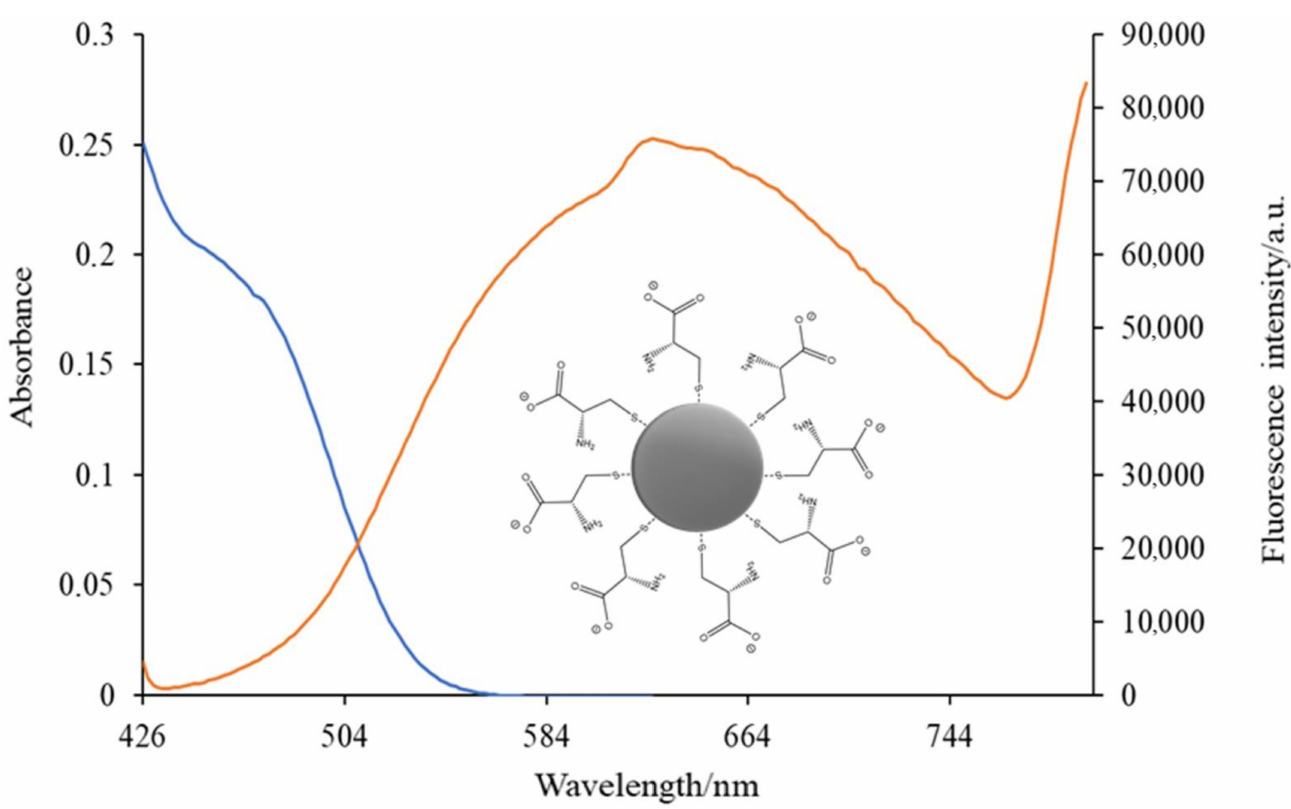
Figure 6. UV–Vis ( left ) and fluorescence ( right ) spectra of the cysteine-capped CdSe QDs in ethanol ( λ ex = 400 nm; λ em = 632